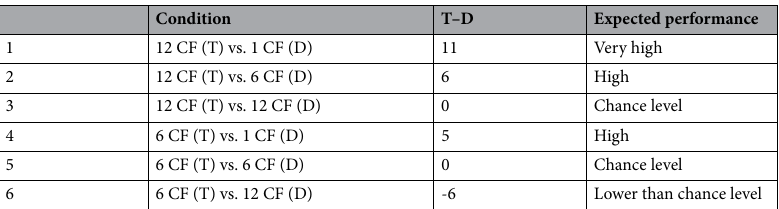
Condition T–D Expected